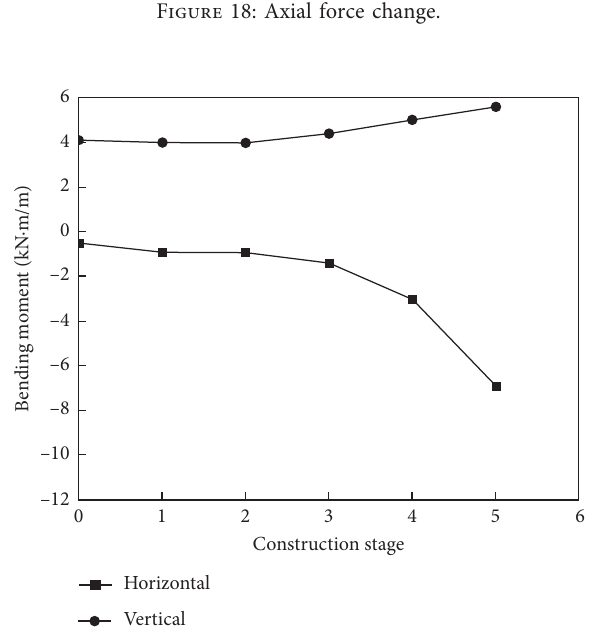
Figure 18: Axial force change.